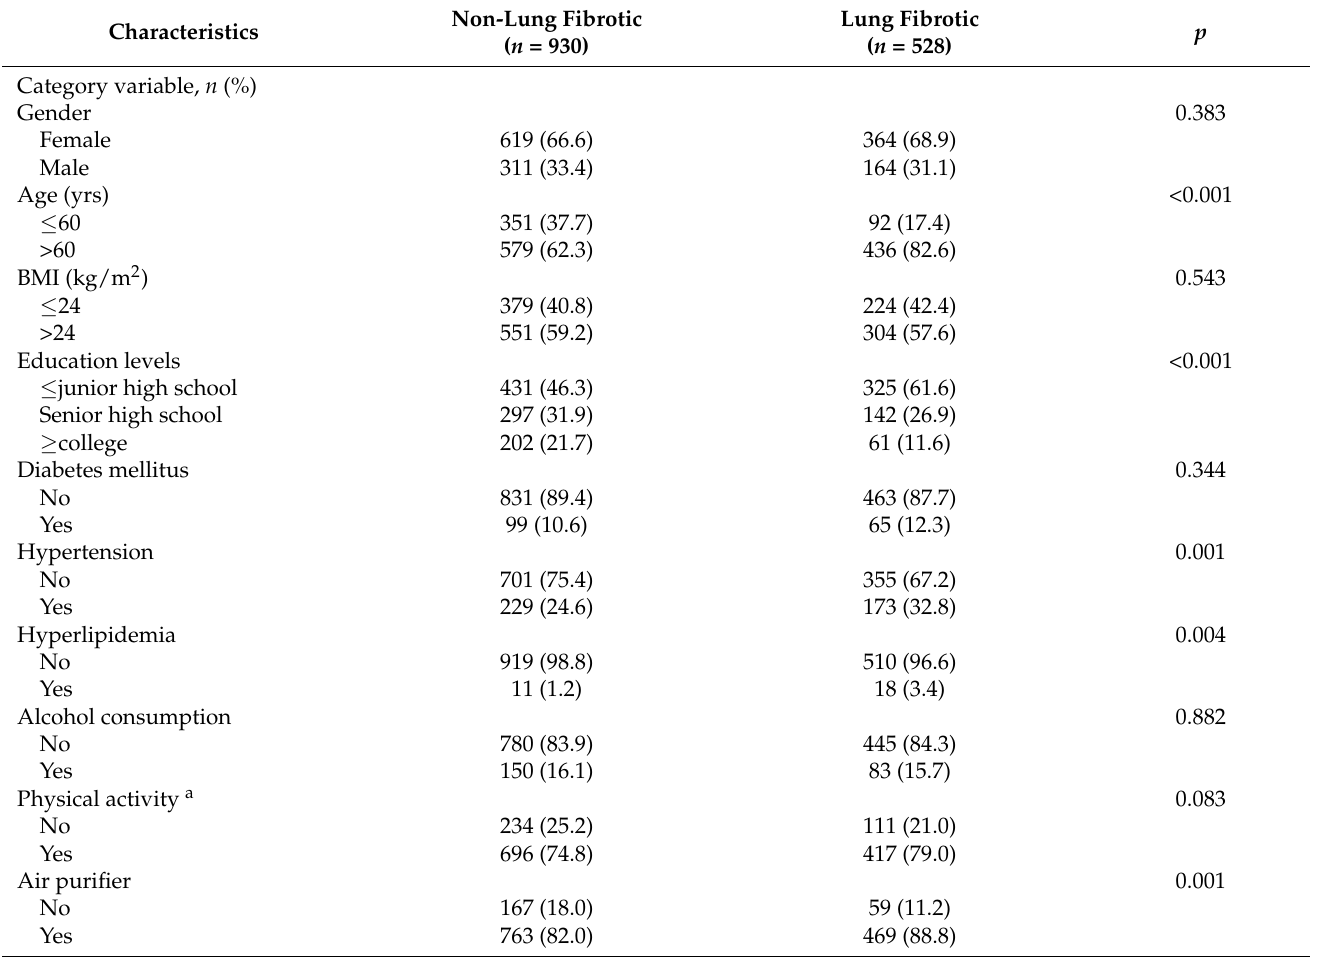
Table 1. Demographic characteristics and blood biochemistry levels of participants between lung fibrotic and non-lung fibrotic changes ( n =